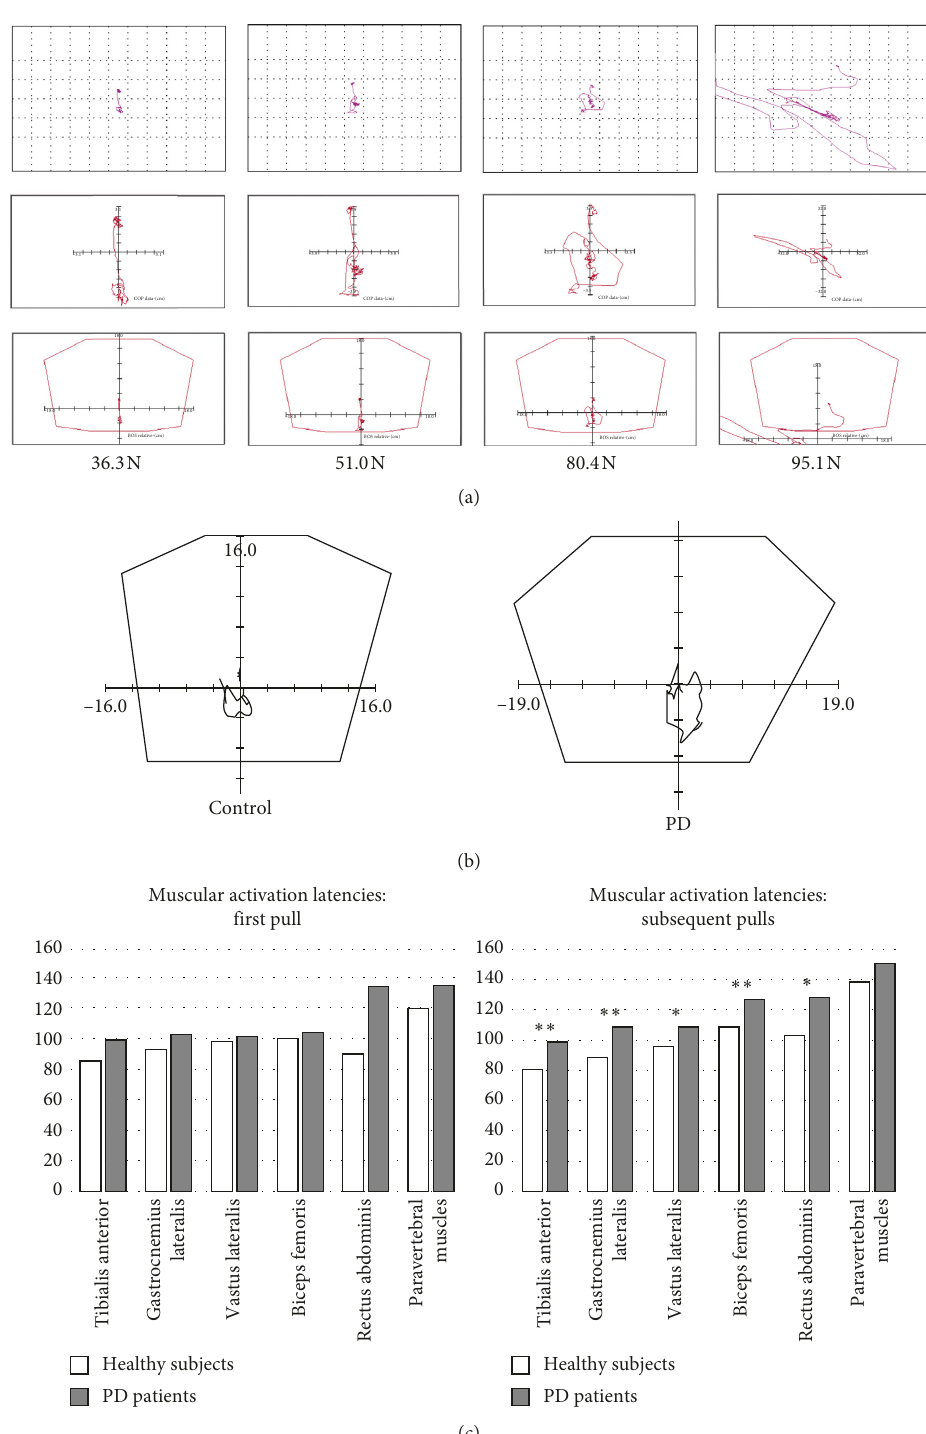
Figure 2: (a) Posturographyexample of a 55yold healthy female:The greater pullforce delivered the greater displacements of the centerof pressure (CoP) provoked. (b) Example of the CoP displacements for a force of 51.0N in a healthy subject and an age- and gender-matched PD patient, which shows a larger area of CoP displacement than the healthy subject. (c) Mean muscular latencies in healthy subjects and PD patients for the first pull and subsequent pulls. ∗ P < 0 . 05 ∗∗ P < 0 .